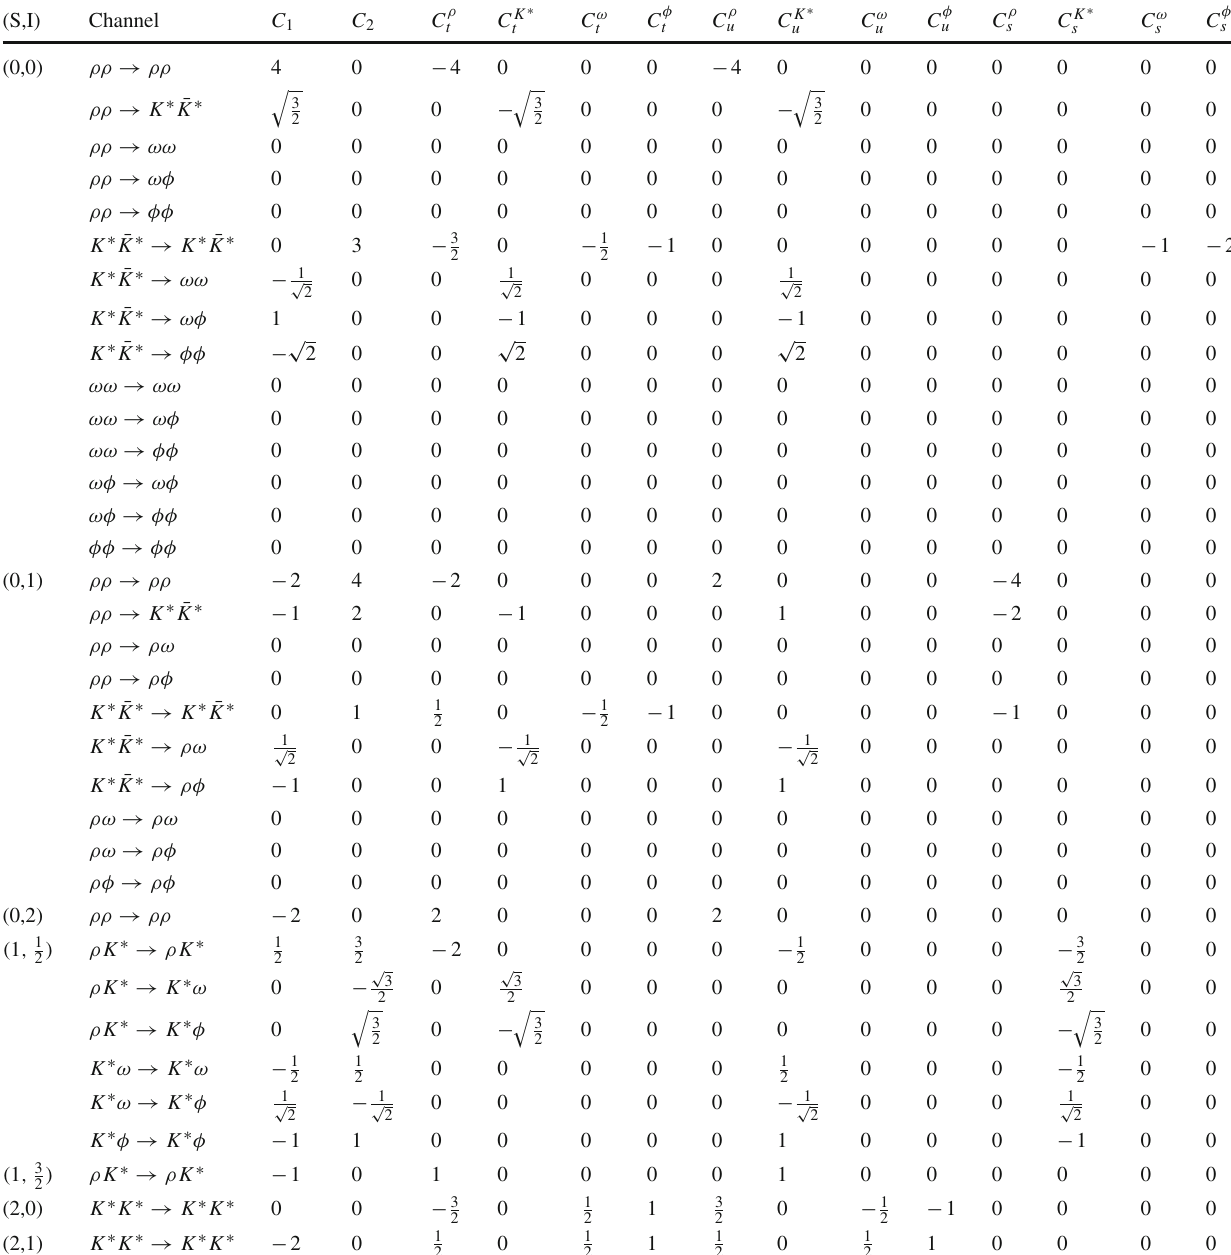
Table 1 Coefficients of the tree-level vector-vector scattering amplitudes in the ( S , I ) basis